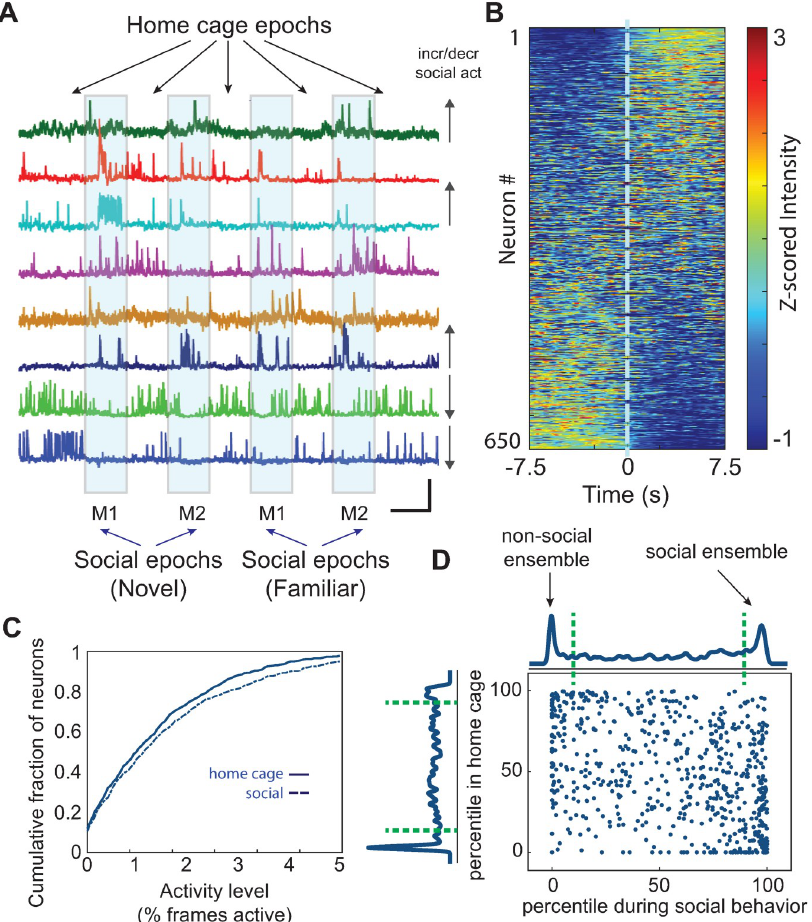
Fig 1. Social interaction modulates activity levels within prefrontal ensembles. (A) Mice were imaged across 9 consecutive behavioral epochs (each lasting 5 minutes) during which they were either alone in their HC or interacted with one of 2 novel sex-matched juvenile mice introduced to the HC (“M1” or “M2”). Each novel mouse was subsequently reintroduced to the HC during a familiar epoch. GCaMP traces show examples of neurons that appear to increase or decrease activity during social epochs (see arrows at the right of each trace). Scale bar: x-axis represents 5 minutes, and y-axis denotes maximum dF/F 0 for each trace (scaled independently). (B) Mean z-scored GCaMP traces for all neurons recorded from WT mice (663 neurons from 10 mice) aligned to the onset of social interaction during the first bout of interaction within each social epoch. (C) Cumulative plot showing the distribution of activity levels for individual neurons during HC epochs or periods of social interaction (% time active in HC: 1.8 +/ − 0.1%, % time active during social interaction: 2.1 +/ − 0.1%, p = 0.00002, paired t test; n = 663 neurons from 10 WT mice). (D) Scatter plot showing the activity of each neuron during each behavioral condition, expressed as a percentile relative to a null distribution generated by circularly shuffling that neuron’s activity. Activity levels during social interaction or while the mouse was alone in its HC are plotted on the x-axis and y-axis, respectively. Kernel density plots along the axes indicate the fraction of neurons whose activity was at a given percentile of the null distribution. Neurons with activity > 90th percentile of shuffled datasets (green dotted line) were considered to be positively modulated, whereas neurons with activity < 10th percentile (green dotted line) were considered to be negatively modulated during each behavior ( > 90th percentile, social: 152/663 neurons, HC: 80/663 neurons; p < 0.00001, chi-squared test; < 10th percentile, social: 128/663 neurons, HC: 119/663 neurons; p = 0.5, chi-squared test). Data used to generate this figure can be found in the Supporting information Excel spreadsheet (S1 Data). HC, home cage; W AU : AbbreviationlistshavebeencompiledforthoseusedthroughoutFigs 1 (cid:0) 6 : Pleaseverifythatallentriesarecorrect : T,